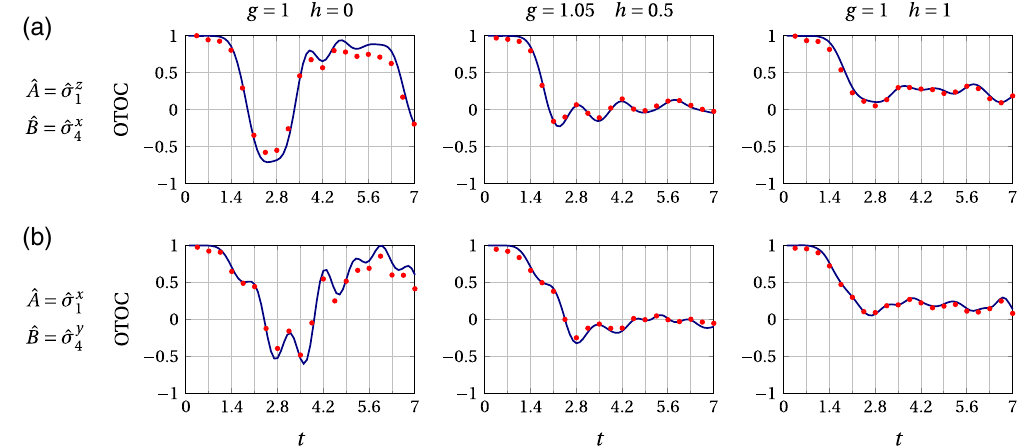
ˆ A ¼ ˆ σ z 1 at the first site and ˆ B ¼ ˆ σ x 4 at the fourth site.